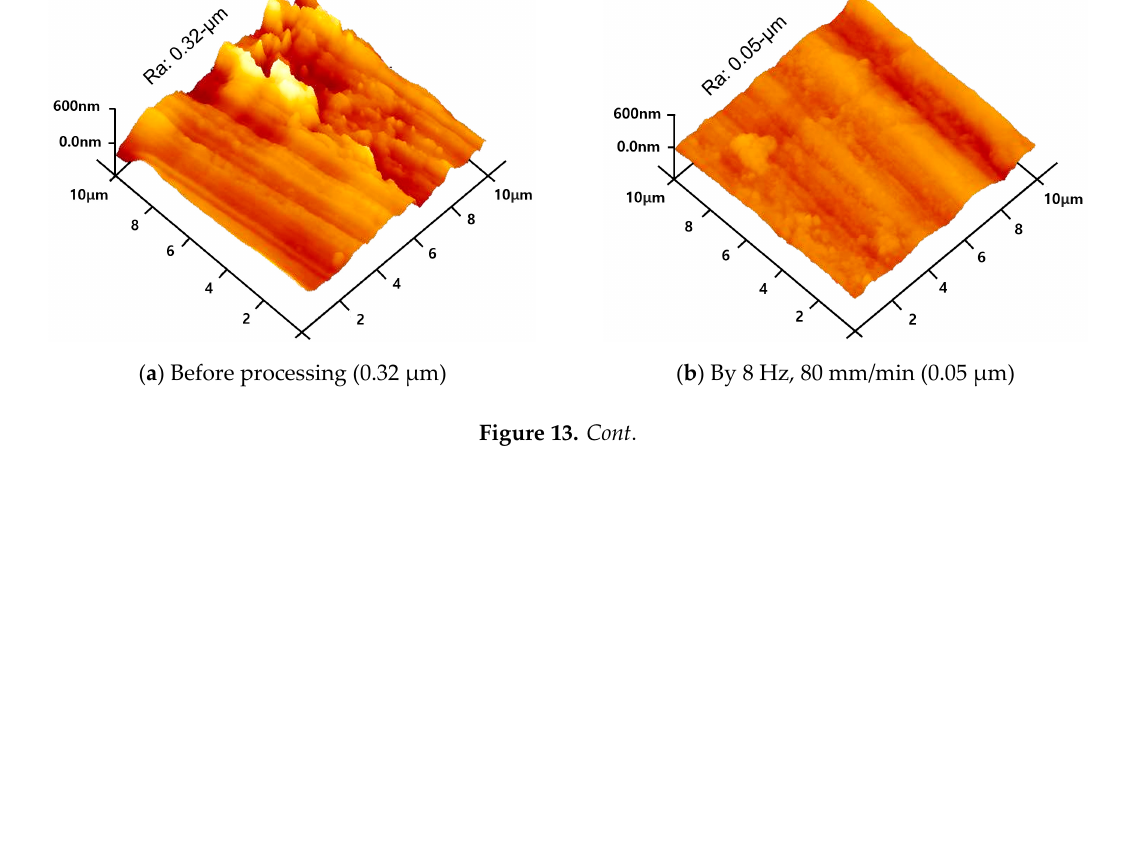
Figure 13. Atomic force microscopy (AFM) 3D image of the workpiece before and after finishing process according to multi-transportation system employed. 4. Conclusions Experiments were conducted to find the optimal processing conditions for beta-titanium. The conclusions are as follows: